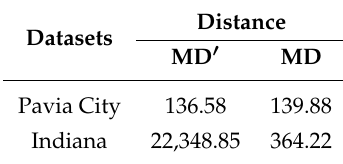
Table 2. Mahalanobis distance between samples from source and